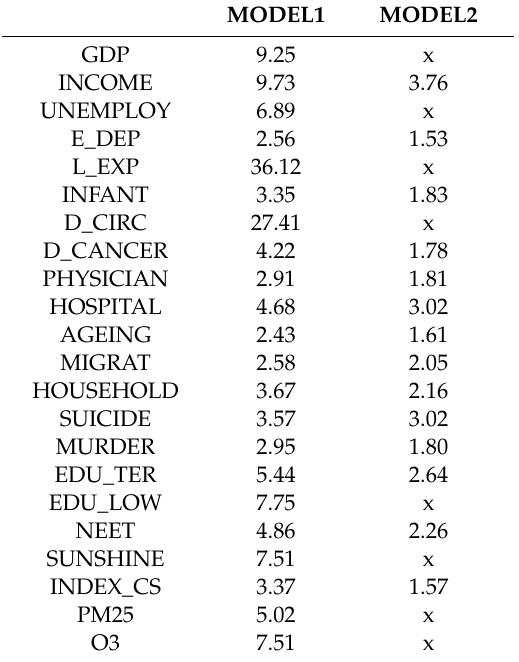
Table 2. Variance inflation factor (VIF) in di ff erent models.